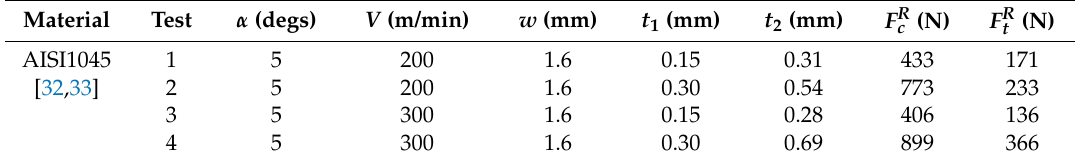
Table 1. Cutting conditions and machining forces in orthogonal machining of AISI 1045 steel. Material